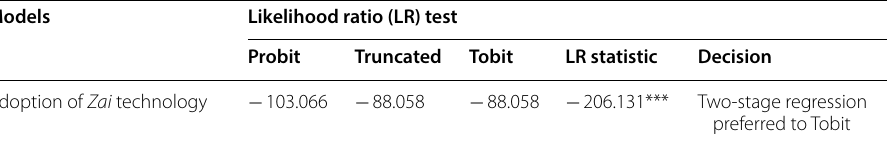
*** Significant level at 1%